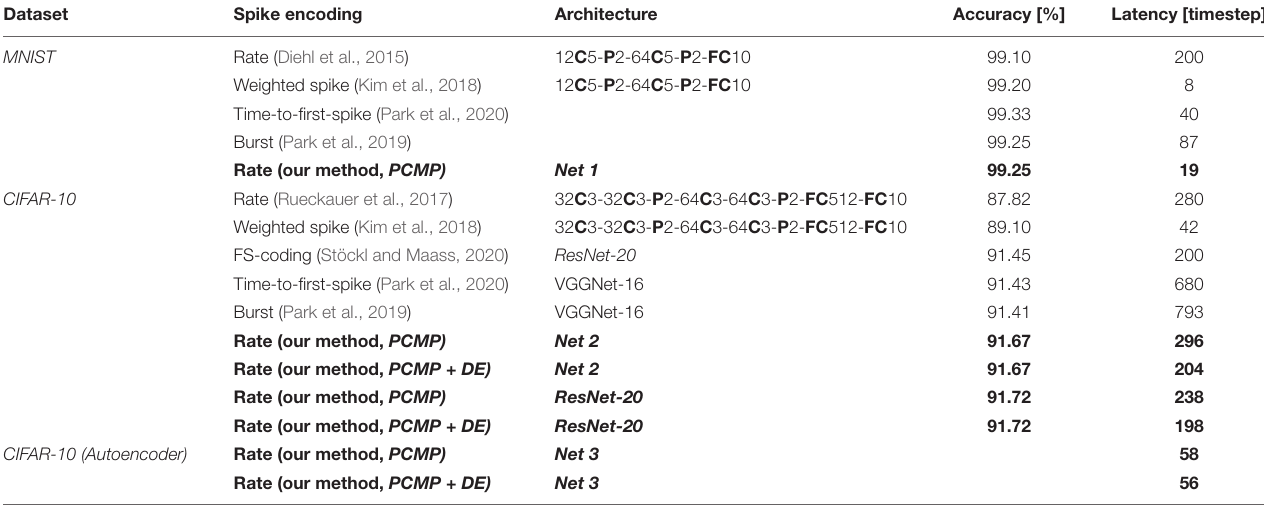
TABLE 3 | Comparison with prior work. Dataset Spike encoding